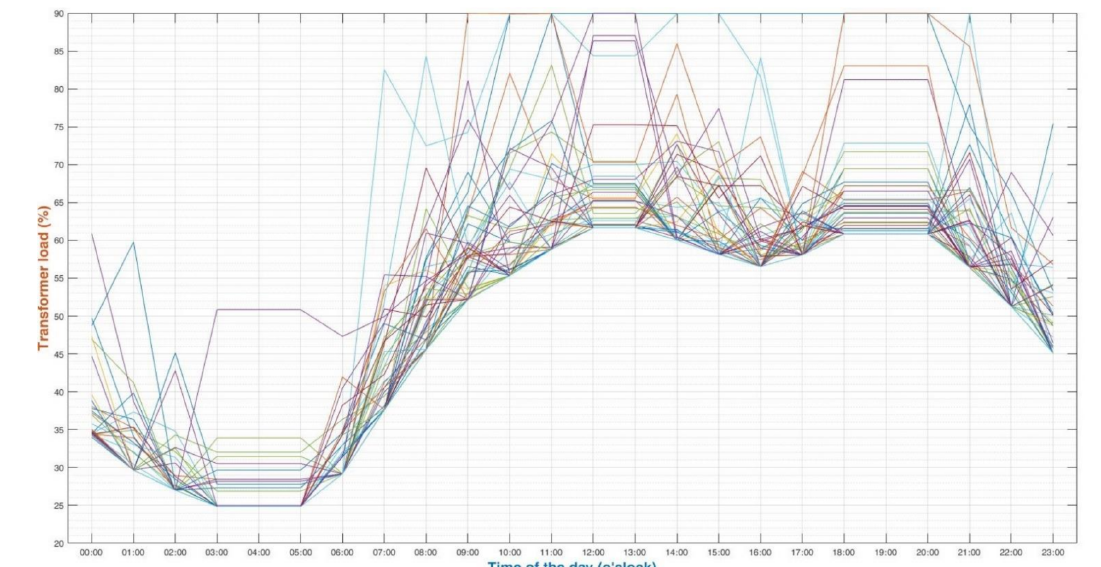
Figure 16. Capacity congestion of the transformers when CS2 (case 2) is